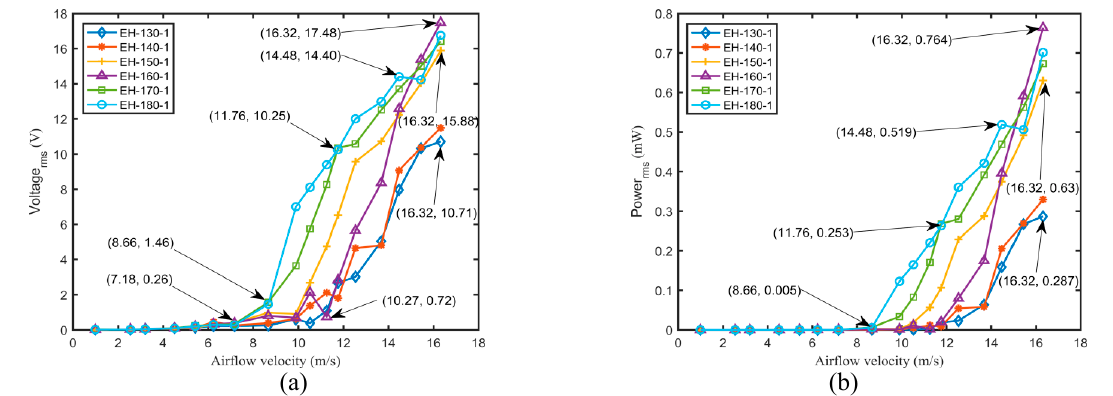
Figure 8. Variations of output voltage ( a ) and output power ( b ) with airflow velocity for various harvesters with a thickness of 1 mm and a resistance of 400 k Ω .